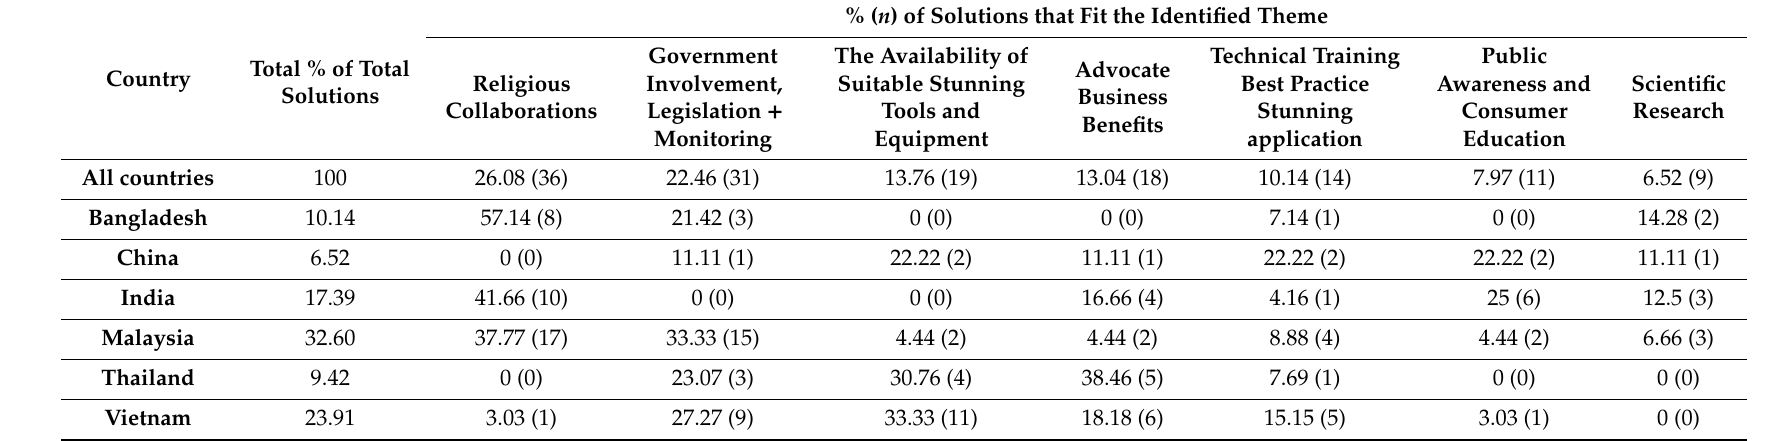
Table 4. Key themes, by country, in response to the question: ‘How to encourage stunning where it isn’t being used?